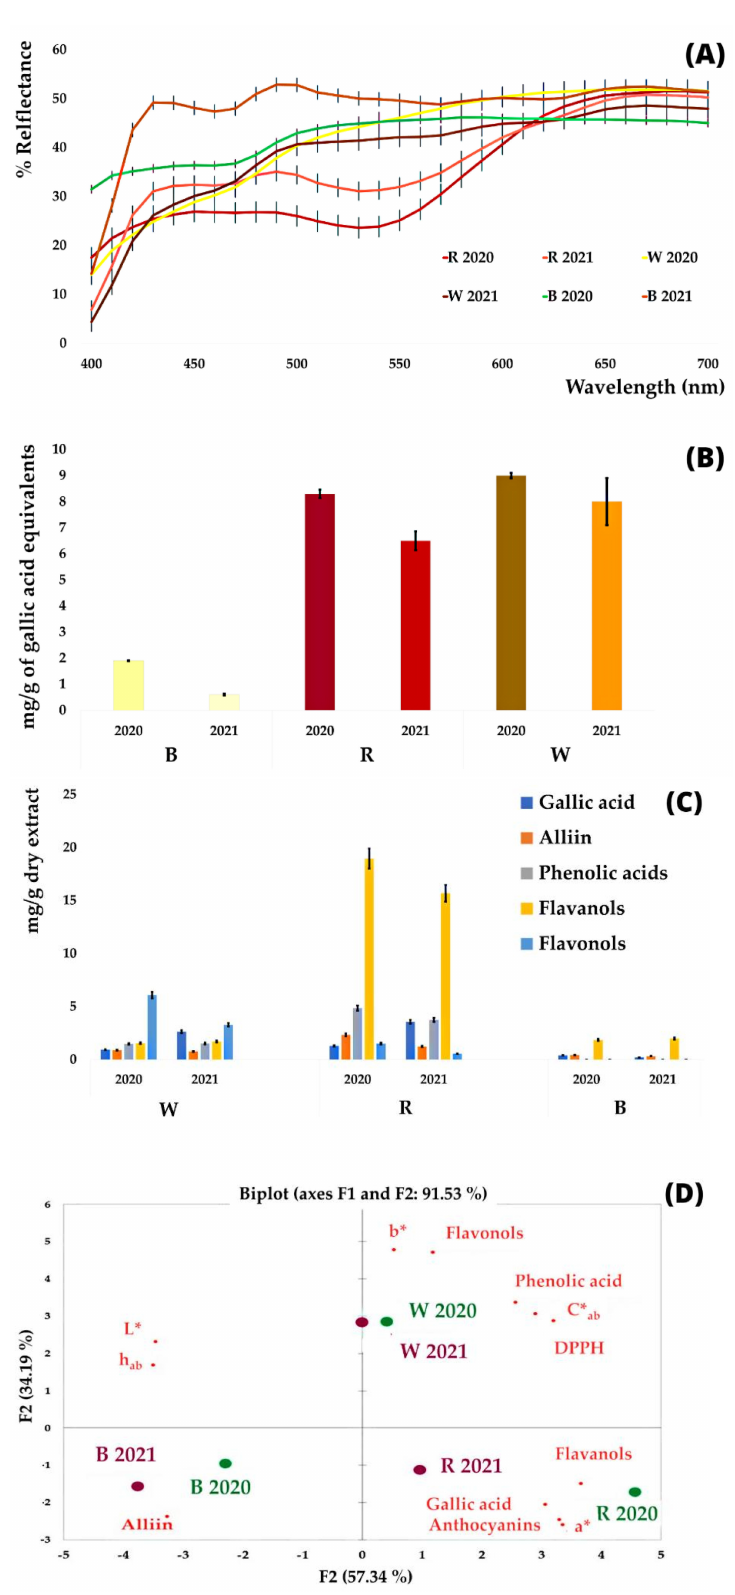
Figure 1. Reflectance curves ( A ), antiradical activity ( B ), bioactive compounds composition according to HPLC-DAD analyses ( C ), and PCA analysis of the obtained hydroalcoholic extracts ( D ). The reported deviation standard (SD) is <5%, p -value ≤